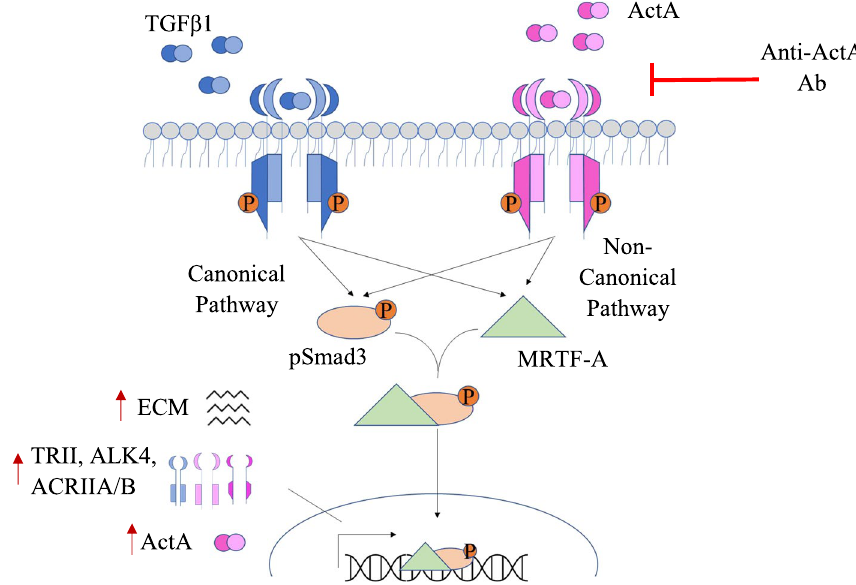
Fig. 8 A schematic representation showing ActA-stimulated Smad3 and MRTF-A signaling converge to enable sustained TGFβ1 profibrotic responses. ActA regulation of TRII and actA receptors, as well as ongoing actA receptor responsiveness to its ligand in contrast to the refractoriness of TGFβ1 receptors to TGFβ1, are important in maintaining profibrotic TGFβ1 signaling. Neutralization of actA attenuates TGFβ1-induced